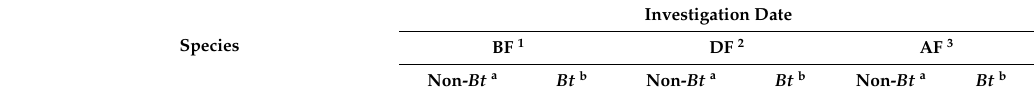
Table 1. Species composition and the temporal dynamics of non-target arthropods (NTAs) in fields planted with transgenic Bt maize and non- Bt maize in Jilin,